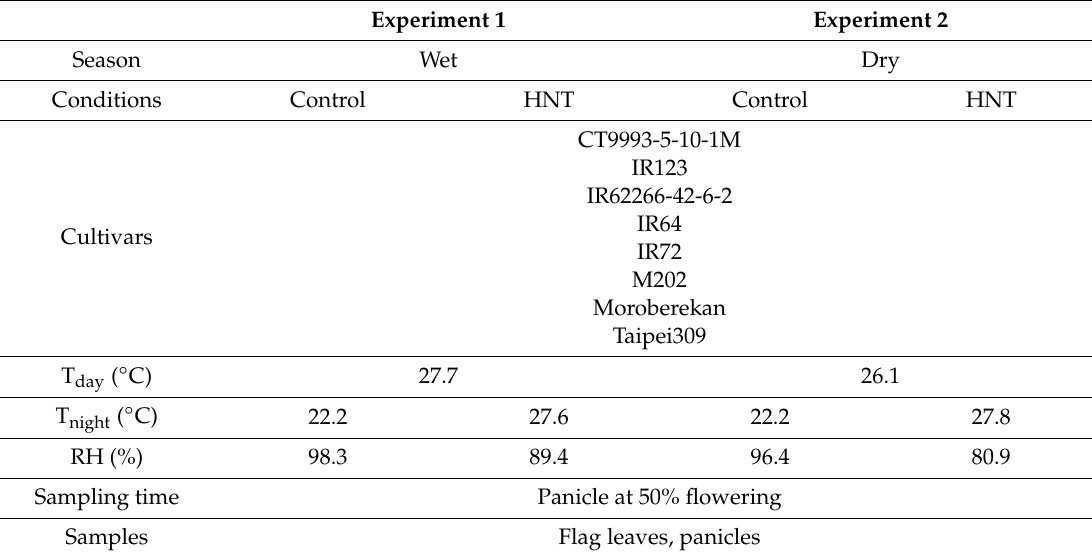
Table 1. Experimental set-up for high night temperature (HNT) field experiments for eight contrasting Oryza sativa cultivars. Mean temperatures and relative humidity (RH) are given from the beginning of HNT treatment till the sampling time, when panicles reached 50%